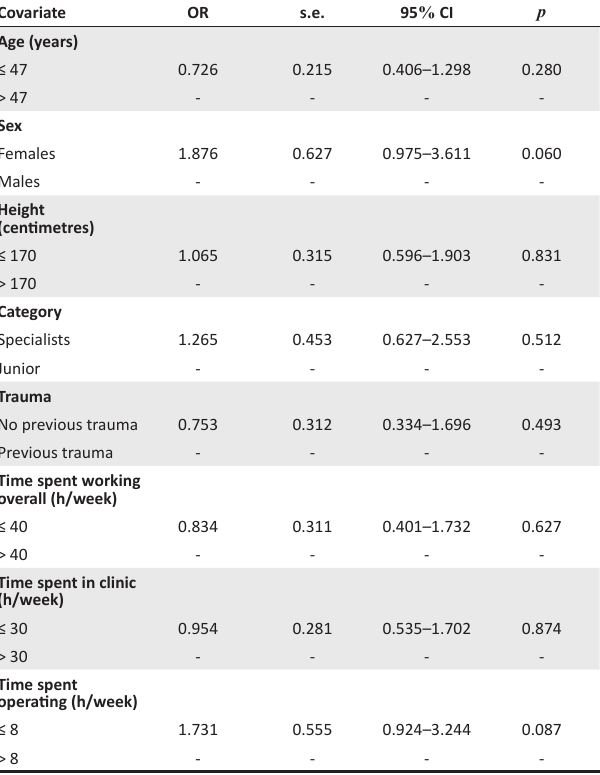
TABLE 3 : Odds ratios and 95 % confidence intervals for the association between various risk factors currently reporting muscular skeletal pain. Covariate OR s.e. 95 %